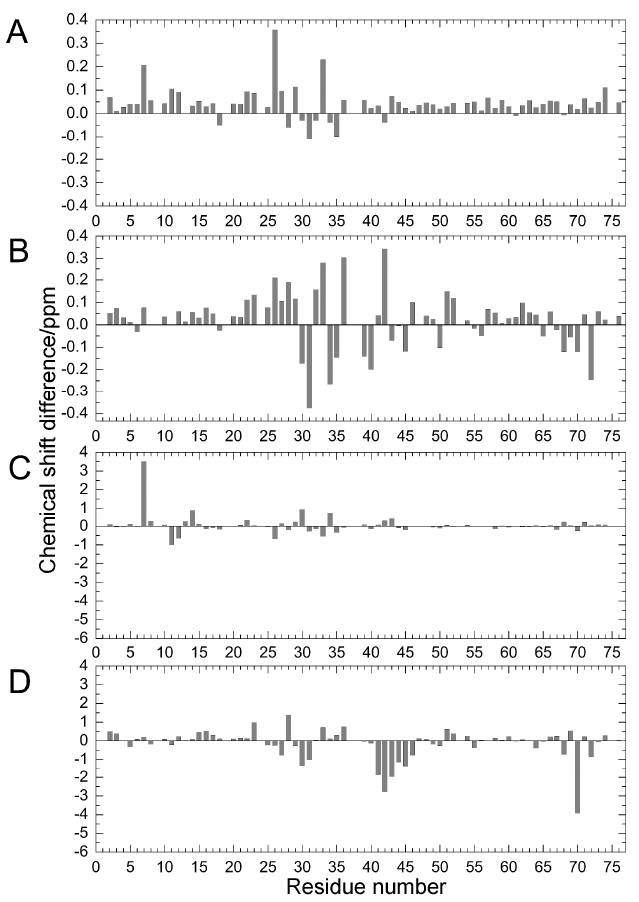
Figure 2. Chemical shift differences ( Δ δ /ppm) between mutants and WT proteins: ( A ) amide 1 H for E34A; ( B ) amide 1 H for Q41N; ( C ) amide 15 N for E34A; and ( D ) amide 15 N for Q41N. Data for Q41N (panels B and D ) were obtained from the literature [22] for comparison (Reproduced with permission from American Chemical Society).